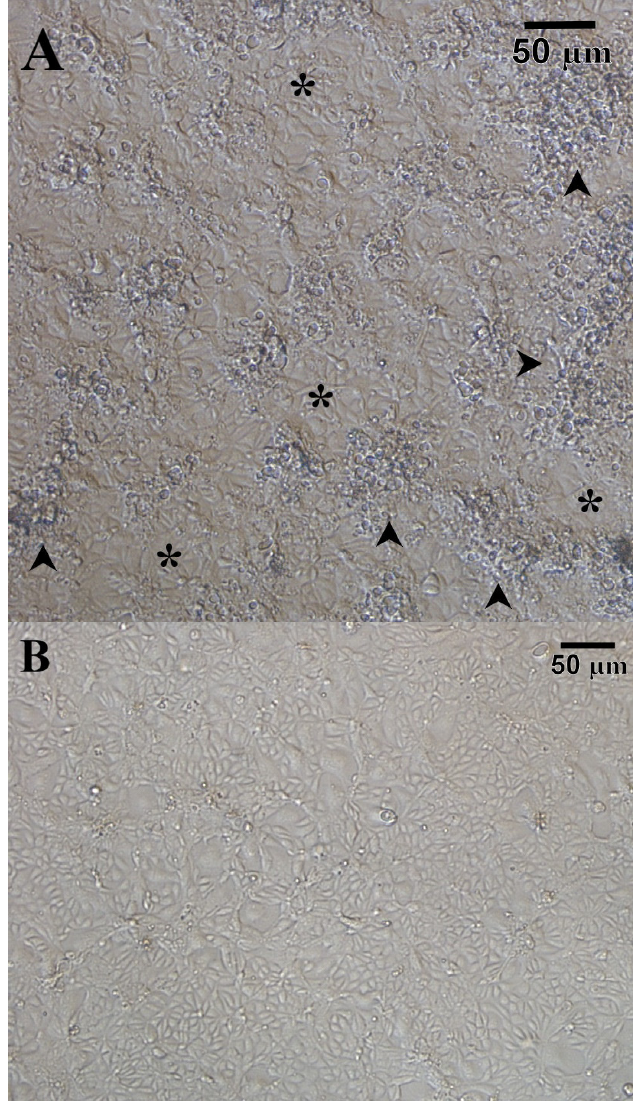
Figure 1. ( A ) Diffuse CPE (arrowheads) and areas of intact monolayer (*) in CHSE-214 cells 5 days after inoculation with CTV-2 isolate CA/BC/2017-111/AtS; (B) healthy, uninfected CHSE-214 cells.